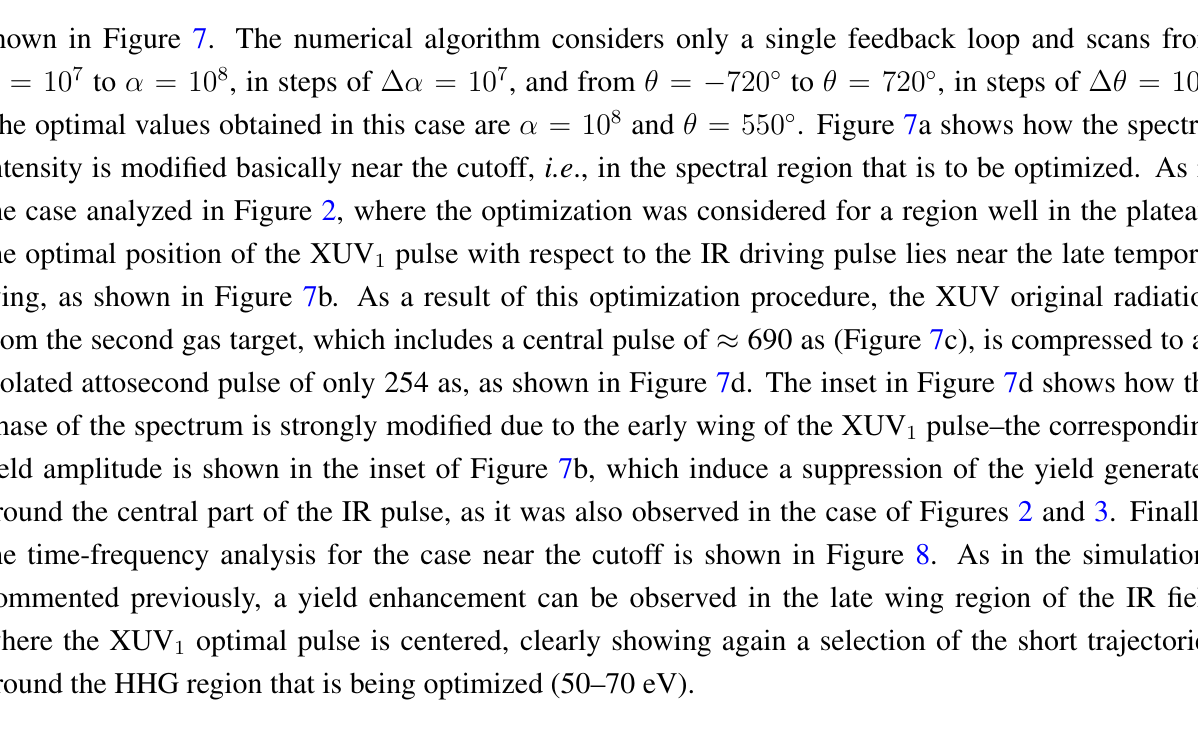
Figure 8. (Color online) Time-frequency analysis of the original ( a ) and optimized ( b ) spectra, for the case shown in Figure